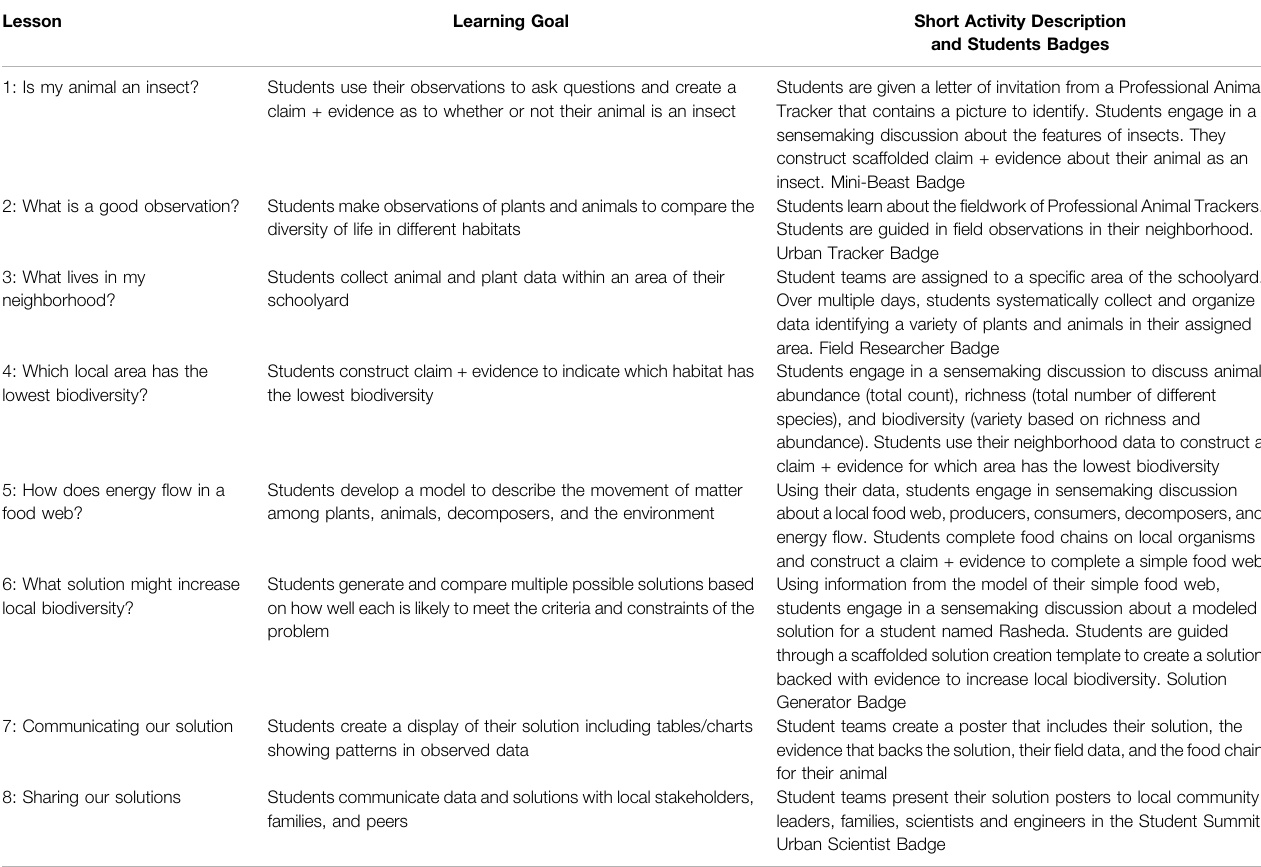
TABLE 2 | Curriculum Story illustrating sequence, learning goals, and short activity